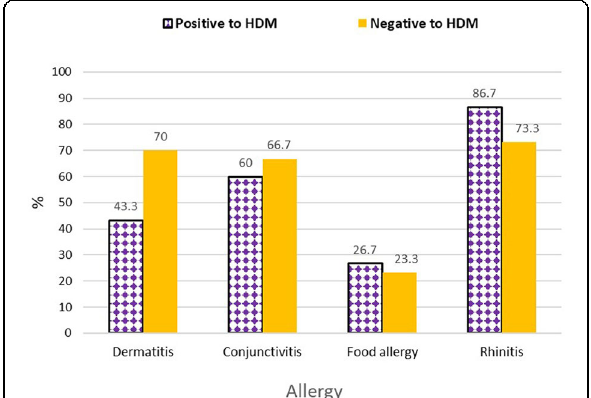
Fig. 1 Allergy type distribution according to sensitivity to